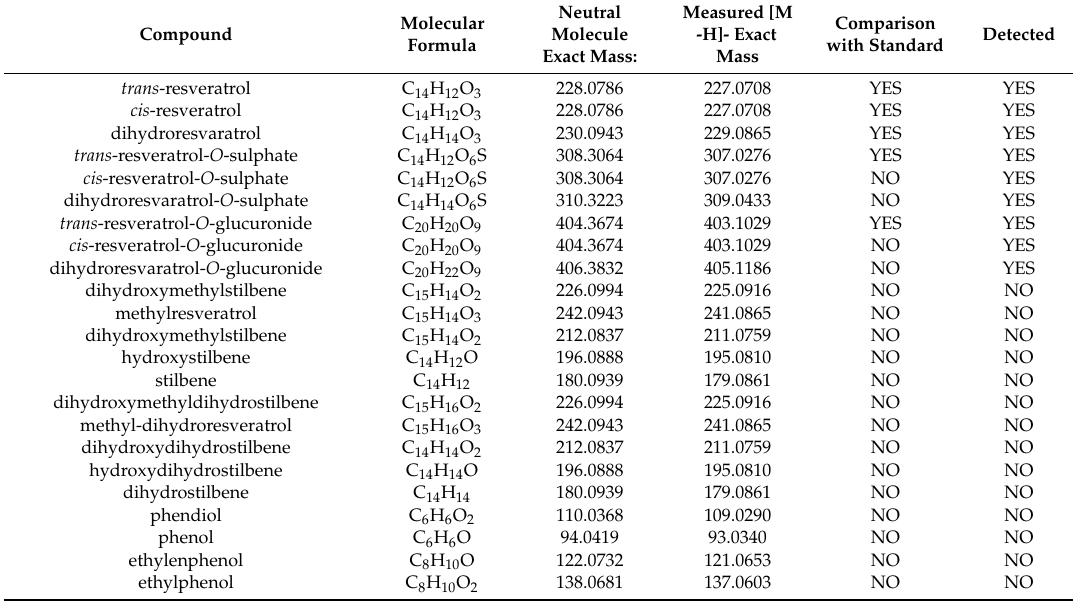
Table A1. List of the stilbenoids monitored and detected in the samples by LC / MS.